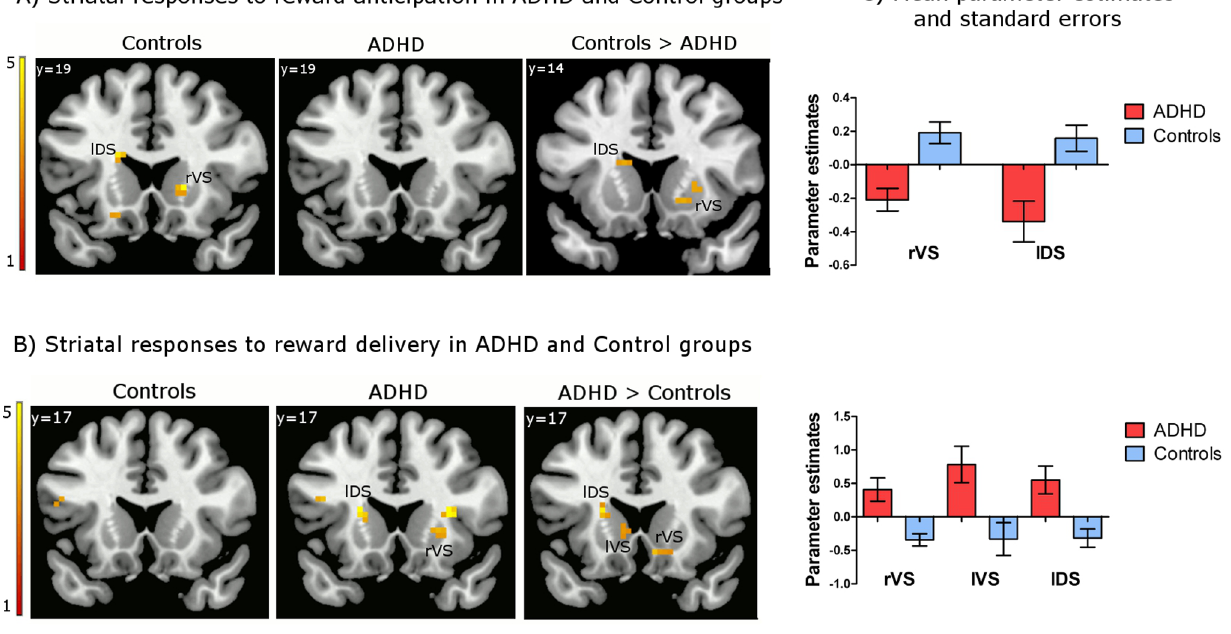
Figure 2. Striatal responses to reward anticipation and reward delivery in the ADHD and control groups. Brain activation displays were generated by overlaying SPM t-maps resulting from the group-level analyses on an MNI standard brain ( p , .005 uncorrected, cluster size $ 5 voxel, for visualization purposes) and applying a gray matter mask. (A) Increased activation in the left dorsal striatum (head of caudate) and right ventral striatum (nucleus accumbens and ventral putamen) during reward anticipation in the control group. (B) Increased activation in the left dorsal striatum (head of caudate), left ventral striatum (ventral regions of the head of caudate), and right ventral striatum (nucleus accumbens and ventral putamen) in response to reward delivery in ADHD. (C) Bar graphs represent mean parameter estimates and standard errors from the GLM analyses examining the effects of reward anticipation (Cue A delay – Cue B delay contrast) and reward delivery (Cue A reward – Cue B non-reward contrast), which were extracted from the local maxima observed within the a priori -defined ROIs based on a meta-analysis (Liu et al., 2011); MNI x, y, z=18, 17, 2 5 for rVS, 2 15, 8, 16 for lDS in response to reward anticipation; MNI x, y, z=9, 17, 2 11 for rVS, 2 9, 17, 1 for lVS, 2 18, 8, 16 for lDS in response to reward delivery. These graphs are provided for illustrative purposes only, and were not used for statistical